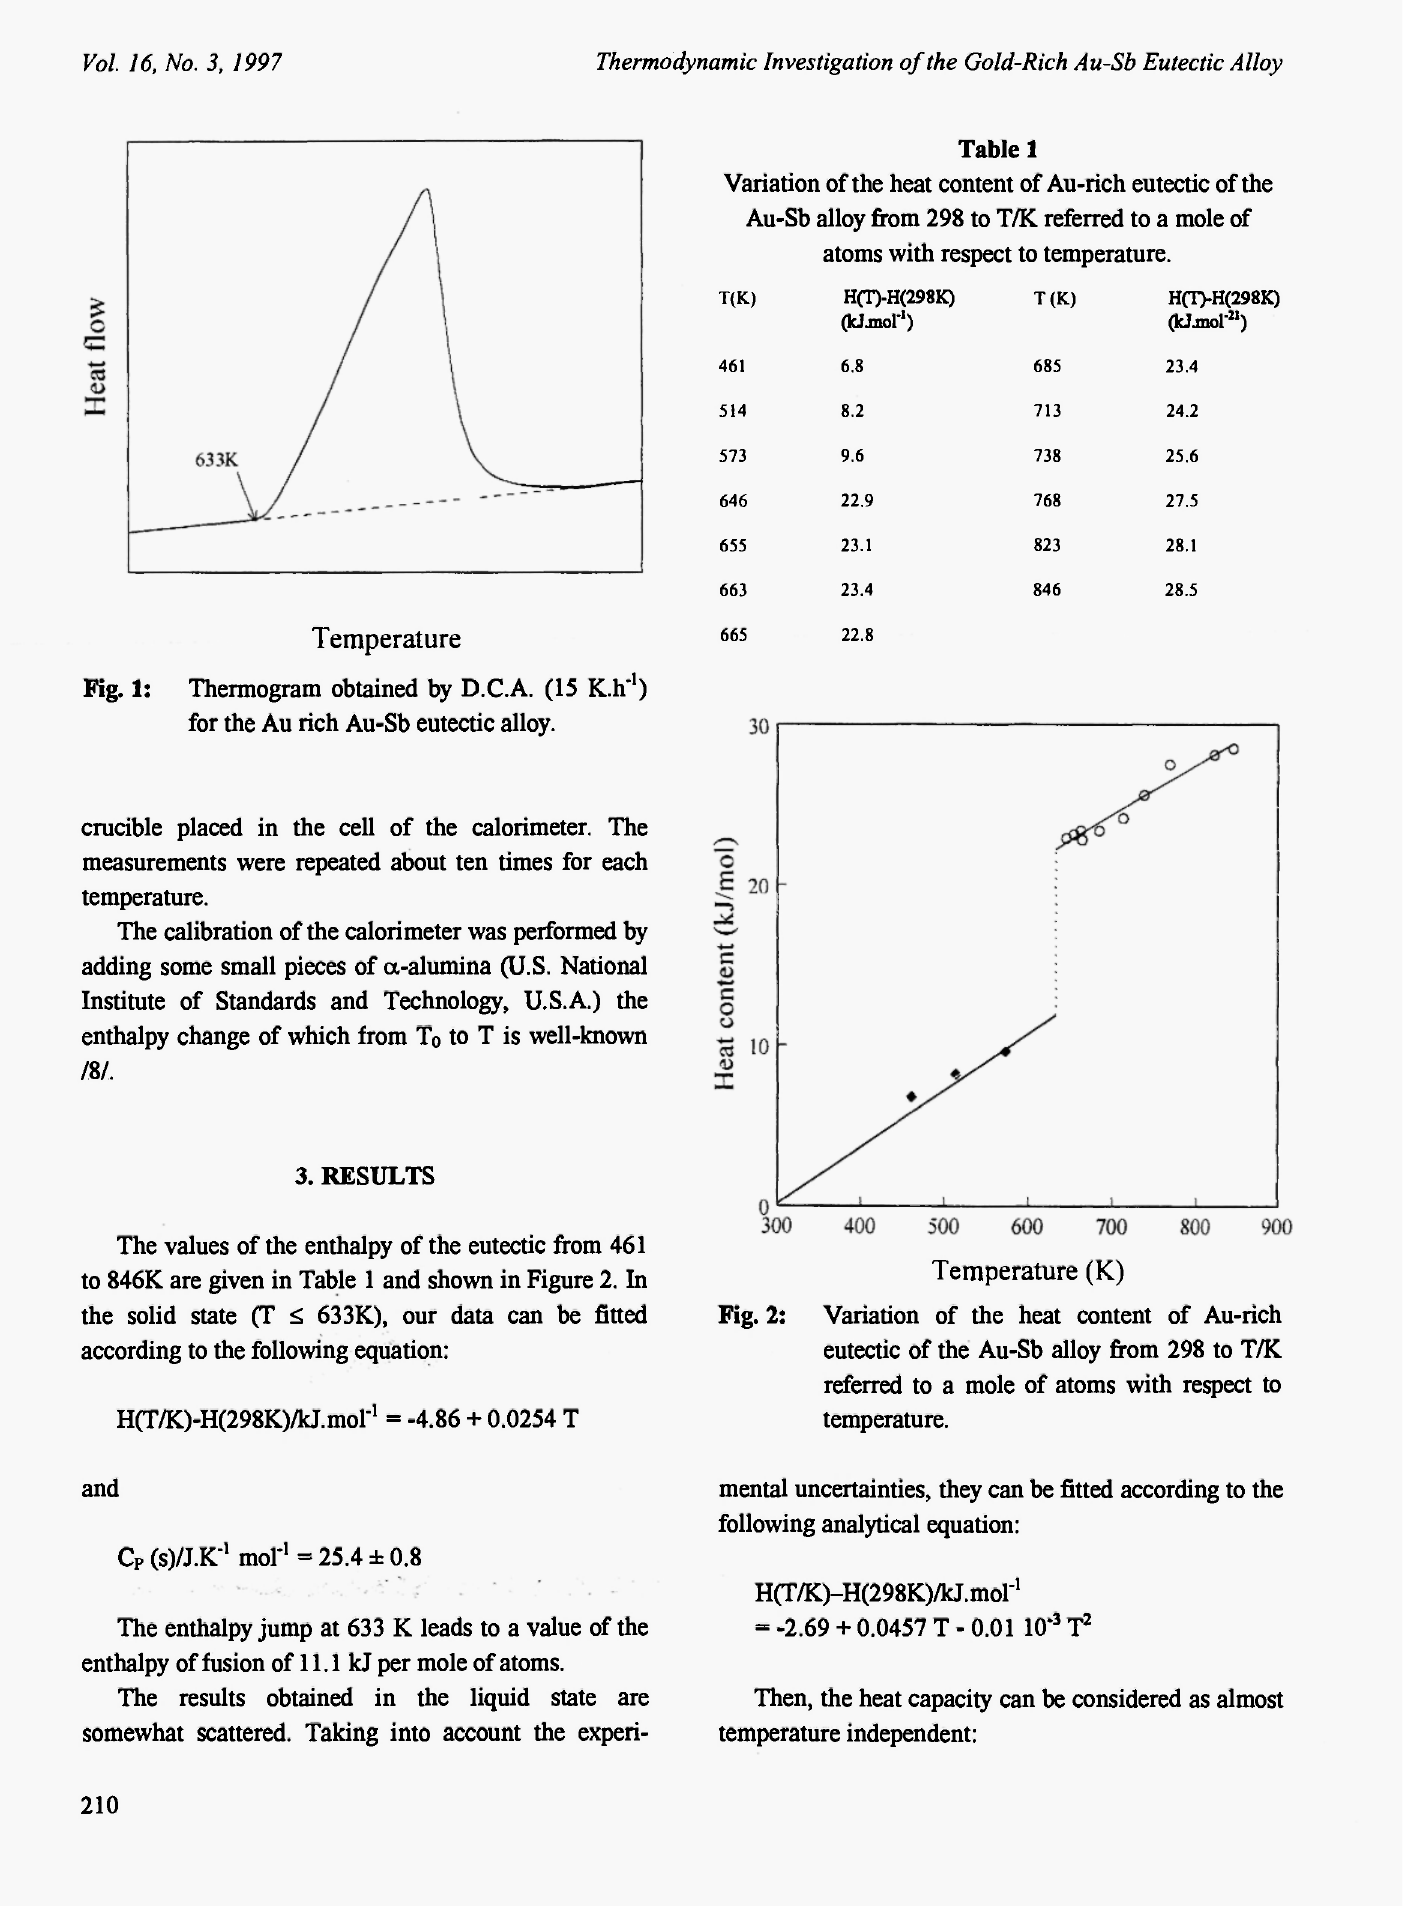
Fig. 2: Variation of the heat content of Au-rich eutectic of the Au-Sb alloy from 298 to T/K referred to a mole of atoms with respect to